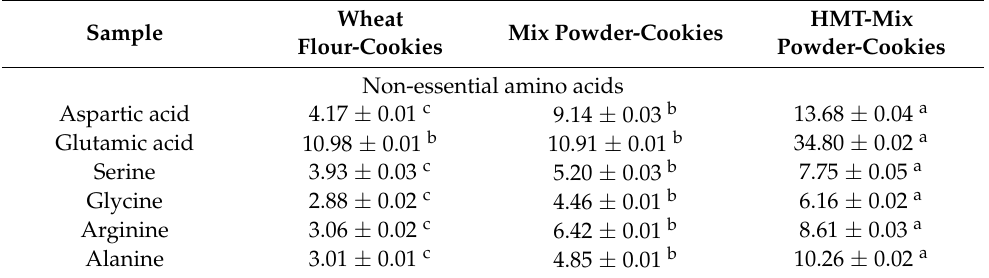
Figure 4. FTIR spectra of dough from wheat flour, mix powders and HMT-mix powder. Table 6. Amino acid composition of cookies as influenced by particle size of black soybean flour (g · kg − 1